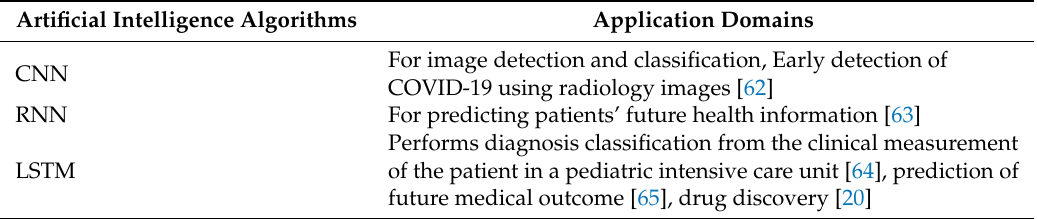
Table 2. Summary of artificial intelligence (AI)